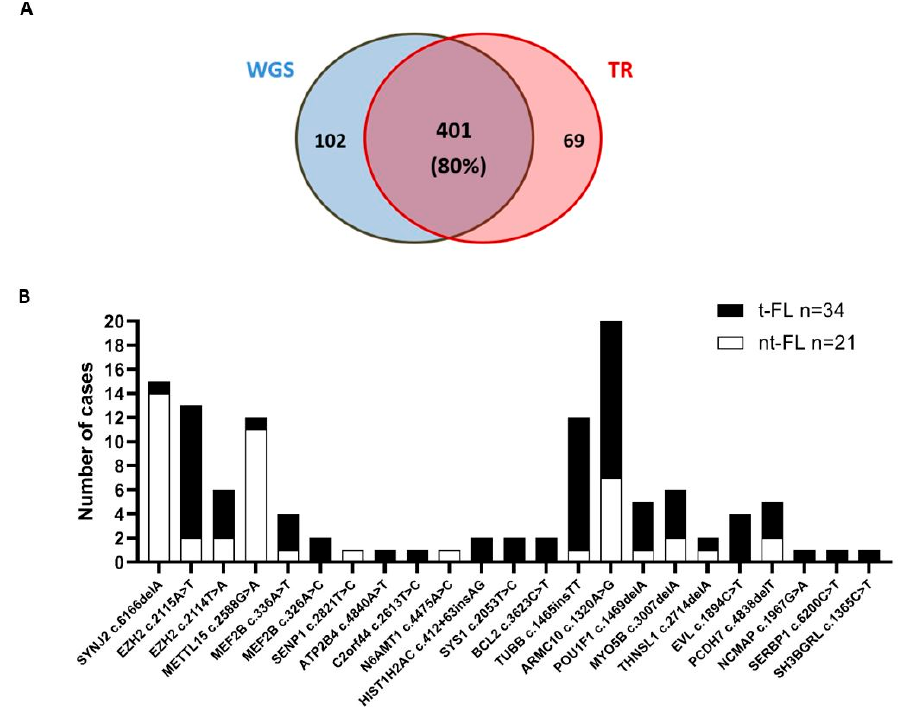
Figure 1. Targeted sequencing results: ( A ) comparison of variants detected by whole-genome sequencing (WGS) and targeted resequencing (TR); ( B ) number of nontransformed (ntFL) and transformed FL cases (tFL) harboring any of the 23 identified recurrent variants after filtering in microRNA (miRNA)-binding sites.